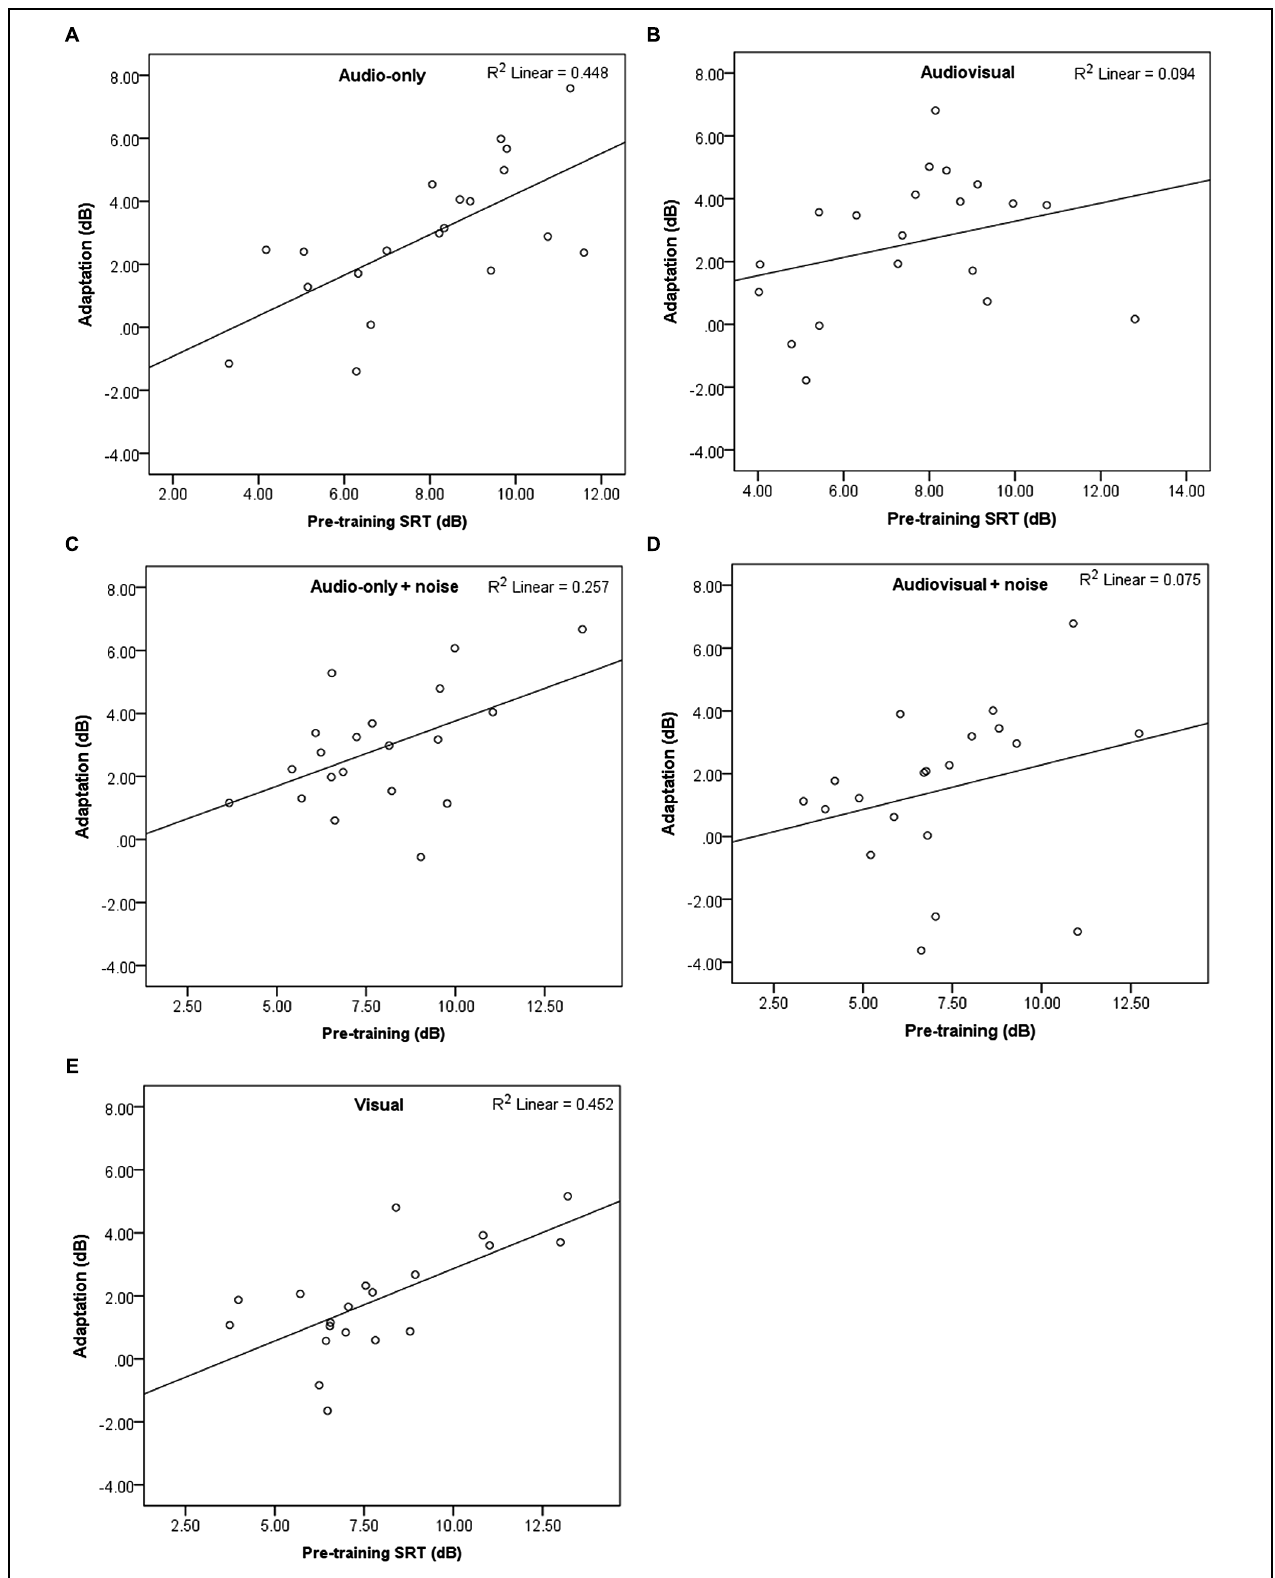
FIGURE 3 | (A–E) Scatterplots showing pre-training SRTs and amount of adaptation with linear fit, per group (Study 1).